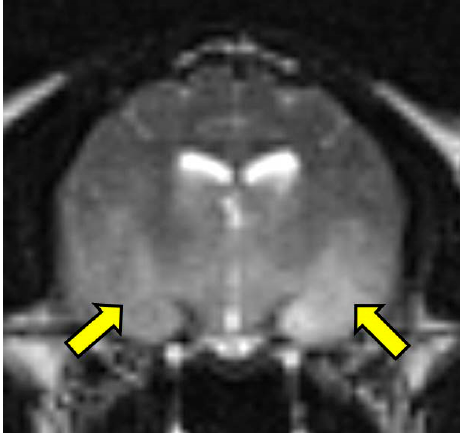
Figure 1. T2 weighted transverse image at the level of the piriform lobe showing the ill-defined, ventrally distributed T2-weighted hyperintensity affecting the piriform lobes, temporal lobes, hypothalamus, and portions of the caudal colliculus and internal capsule (arrows). MRI scan.